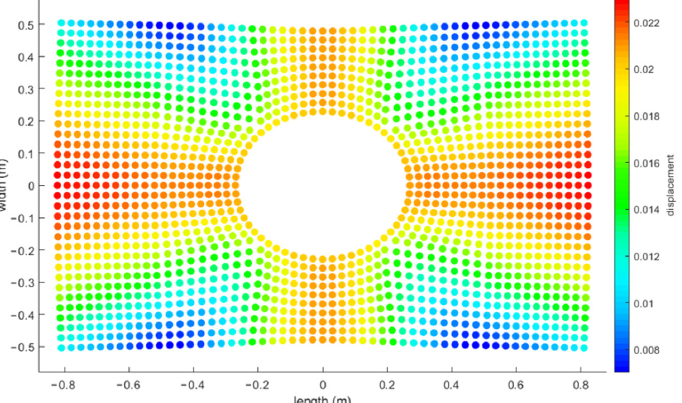
Figure 32. The transient vertical displacement at point B, ∆ t = 0.001 s and c = 1 Ns/m for the Heaviside tension step loading.